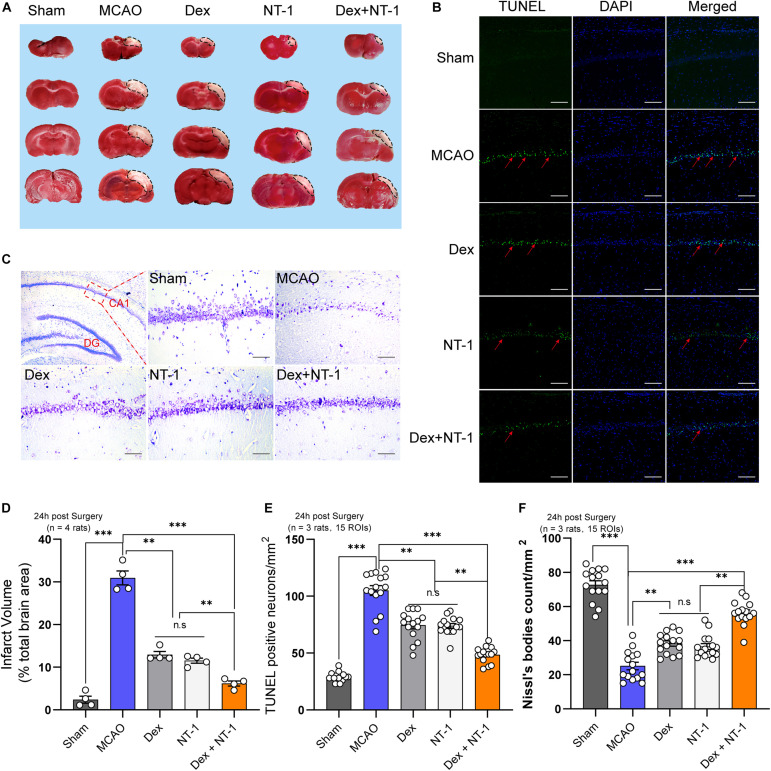
Combination of dexmedetomidine and Netrin-1 reduced the neuronal injury after MCAO injury. (A) TTC staining after MCAO injury, the red area represents normal tissue and the white area represents infarcted tissue. (B) Representative images of TUNEL-positive cells (green) in the hippocampal CA1 region. The nuclei were stained with DAPI. Scale bar = 200 μm. (C) Nissl staining of the surviving cells in the hippocampal CA1 region. Scale bar = 200 μm. (D) Percentage of infarct volume after TTC staining. (E) Quantitative analysis of TUNEL-positive neurons. (F) Quantitative analysis of Nissl-positive neurons. Data are shown as the mean ± SD. ∗∗P < 0.01 and ∗∗∗P < 0.001 using one-way ANOVA followed by Tukey’s post hoc tests.